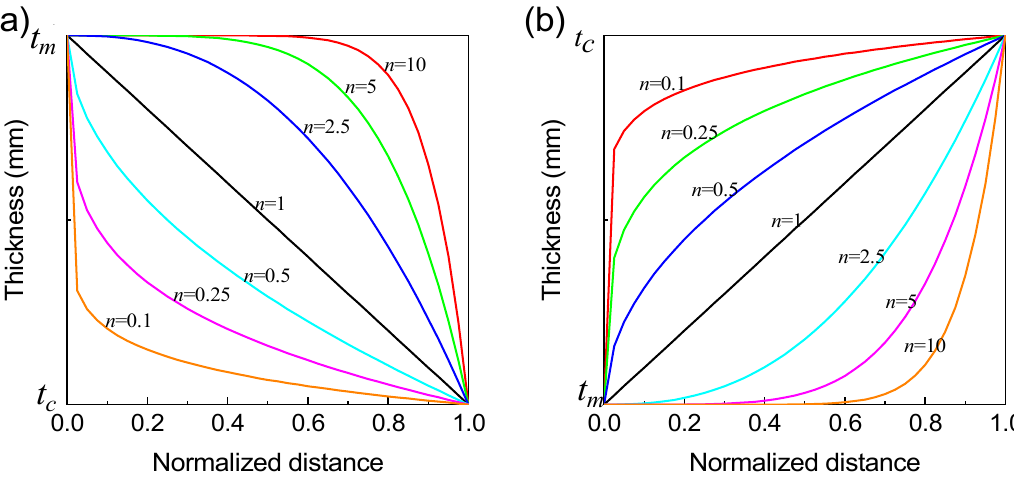
Figure 3. Thickness variation versus normalized distance x/L for ( a ) t m > t c and ( b ) t m < t c .